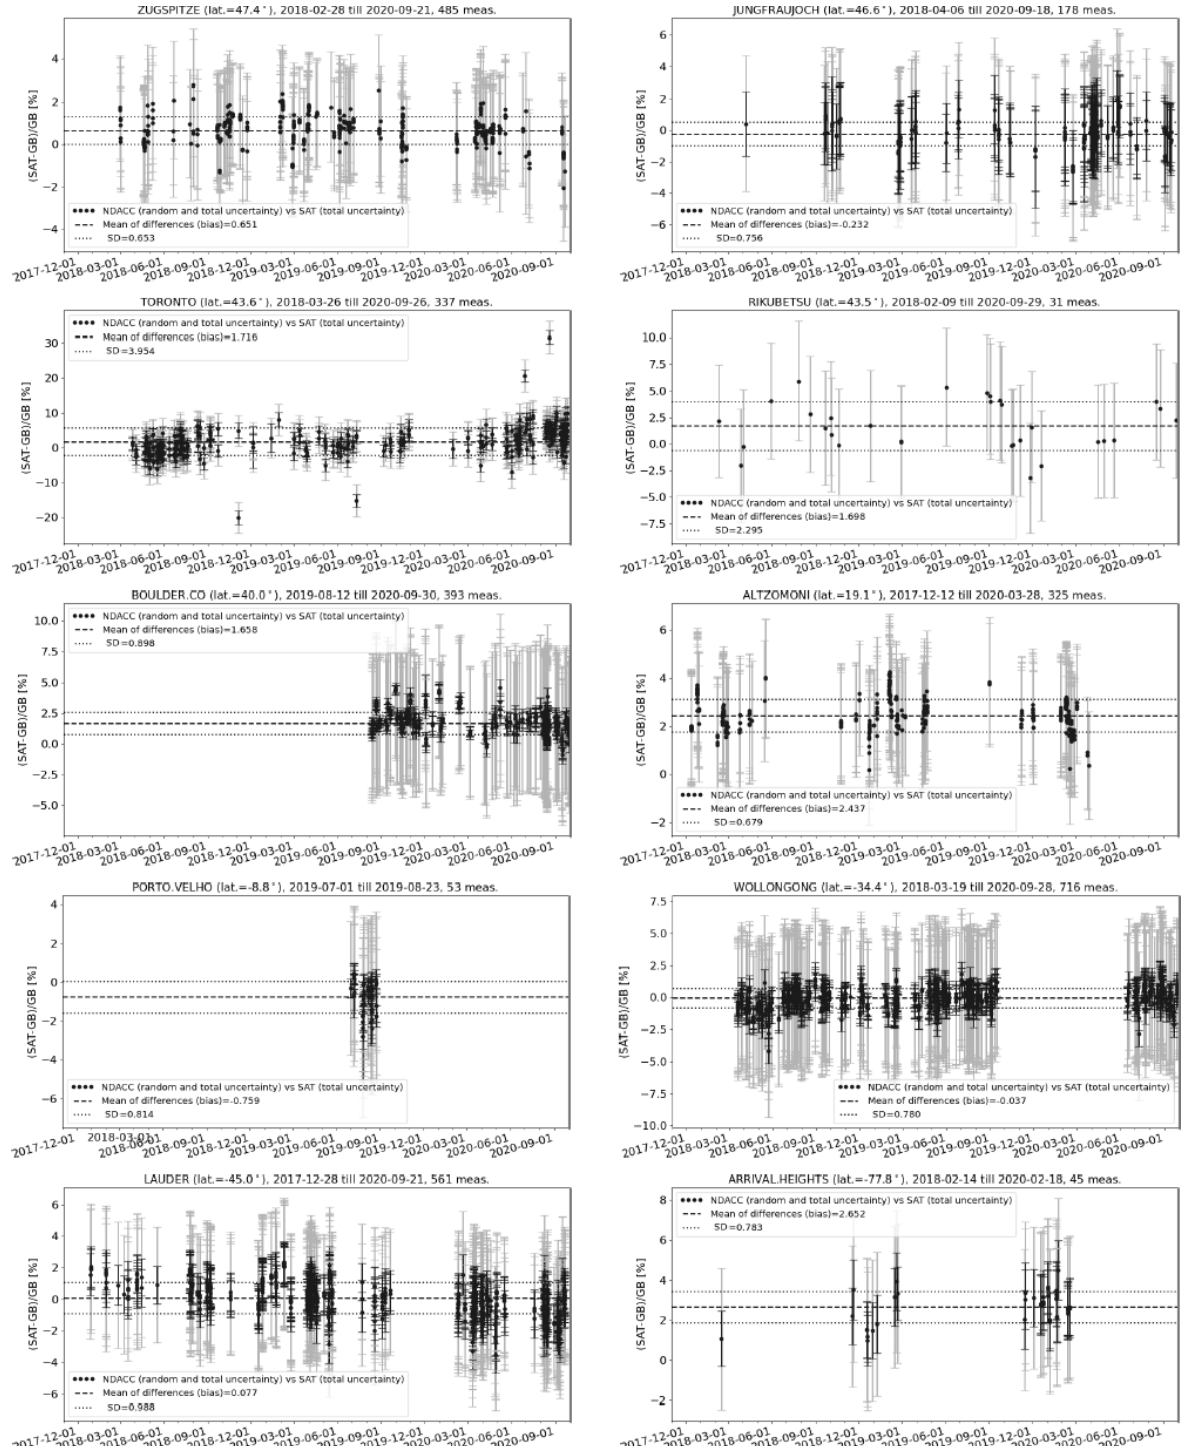
Figure 15. Same as Fig.